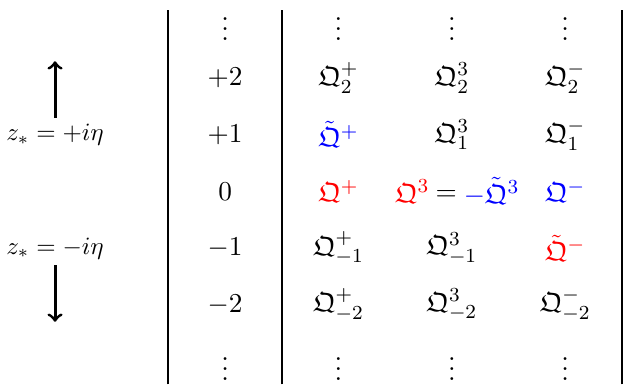
Figure 2 . The charges and their grades for the expansion of the monodromy matrix around the pair of special points z = (cid:6) i(cid:17) . The blue/red and positive/negative graded charges are associated to (cid:6) i(cid:17) , respectively. The red and blue charges generate the a(cid:14)ne quantum group in homogenous gradation and all the other charges are obtained by repeated Poisson brackets of these